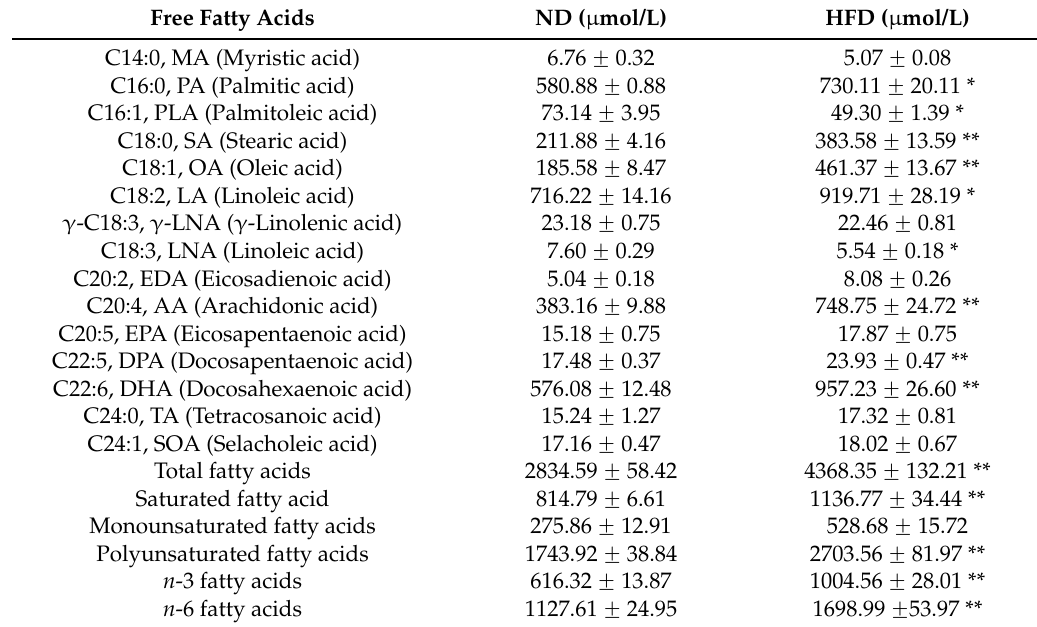
Table 1. Composition of Plasma FFAs in ND and HFD mice.